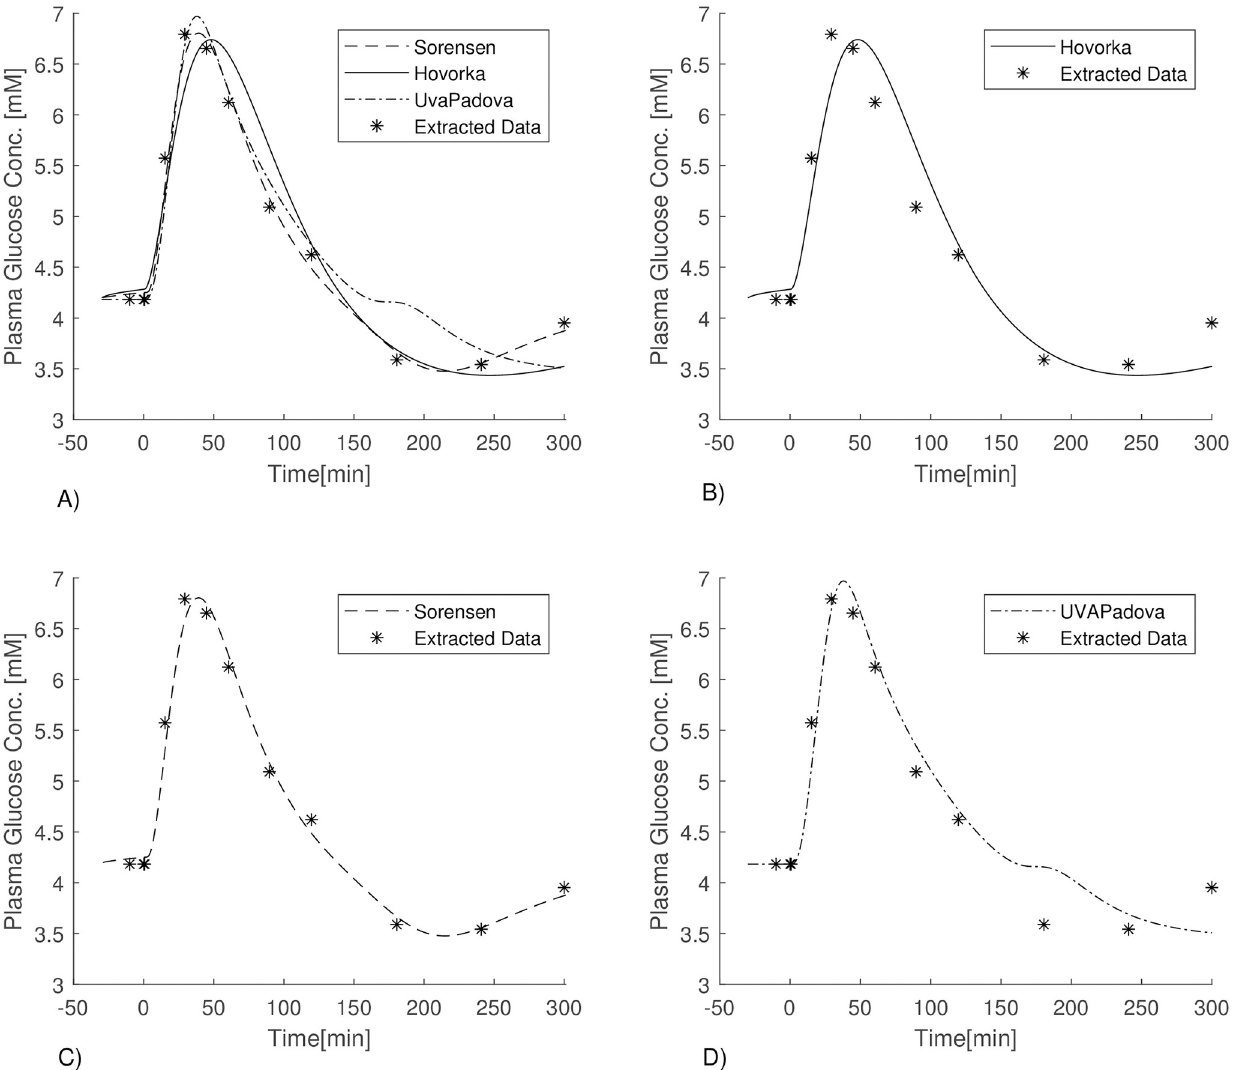
Fig 6. A)Blood glucose concentrations of Sorensen (dashed line), Hovorka (solid line), UVAPadova (dashed dotted line) models with data points from Sorensen PhD thesis (asterisks); B) Hovorka (solid line) vs data points (asterisks); C) Sorensen (dashed line) vs data points (asterisks); D) UVAPadova (dashed dotted line) vs data points